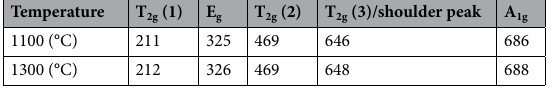
Table 2. Raman spectra peaks and related active